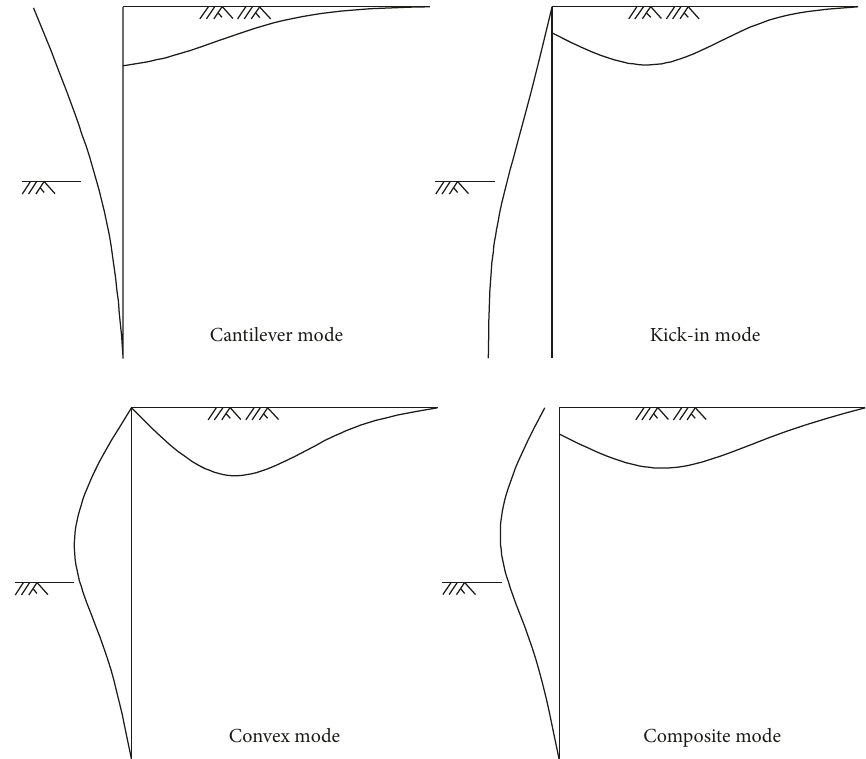
Figure 9: Typical profiles of diaphragm wall